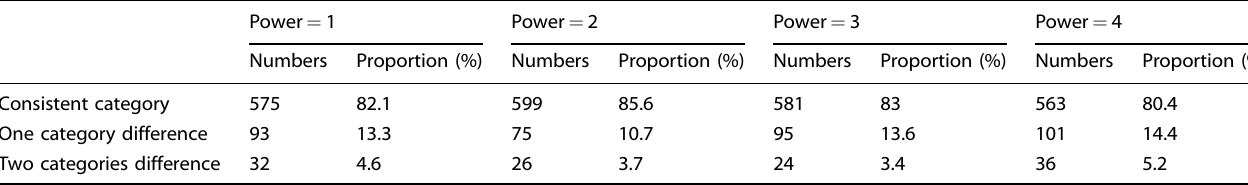
Table 4. Statistics of sites corrosion categories prediction results by cross